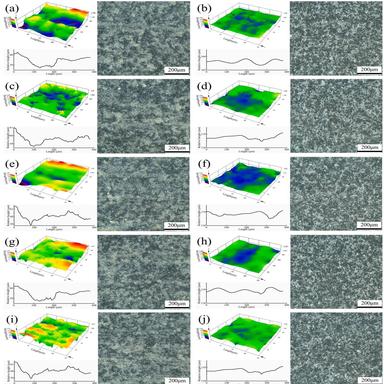
Surface topography of workpieces: (a) 60 g/min before MAF; (b) 60 g/min after MAF; (c) 120 g/min before MAF; (d) 120 g/min after MAF; (e) 180 g/min before MAF; (f) 180 g/min after MAF; (g) 240 g/min before MAF; (h) 240 g/min after MAF; (i) 300 g/min before MAF; (b) 300 g/min after MAF.